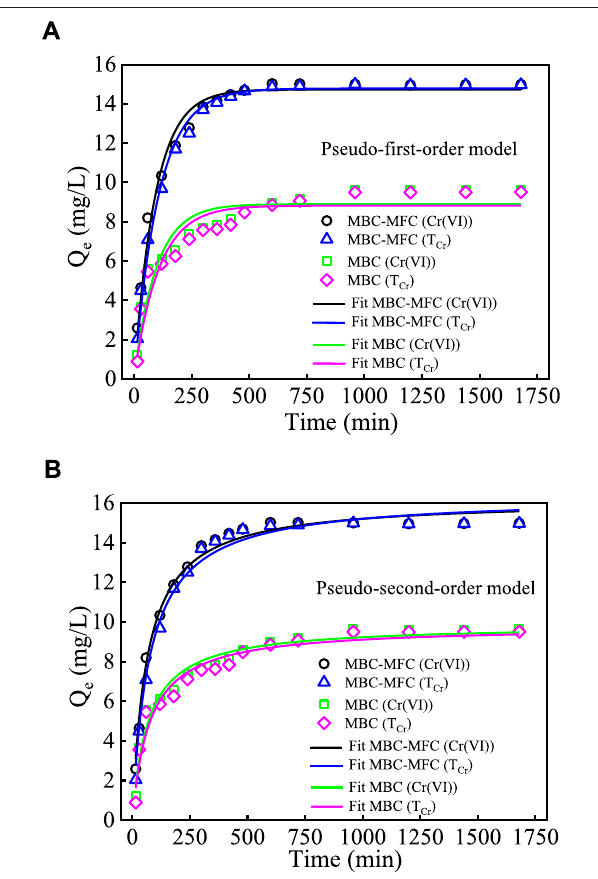
FIGURE 5 | The Cr(VI) and T Cr removal kinetics fi tted with pseudo- fi rst- order model and pseudo-second-order model ( T (cid:1) 25 ° C, pH (cid:1) 3.0, and C